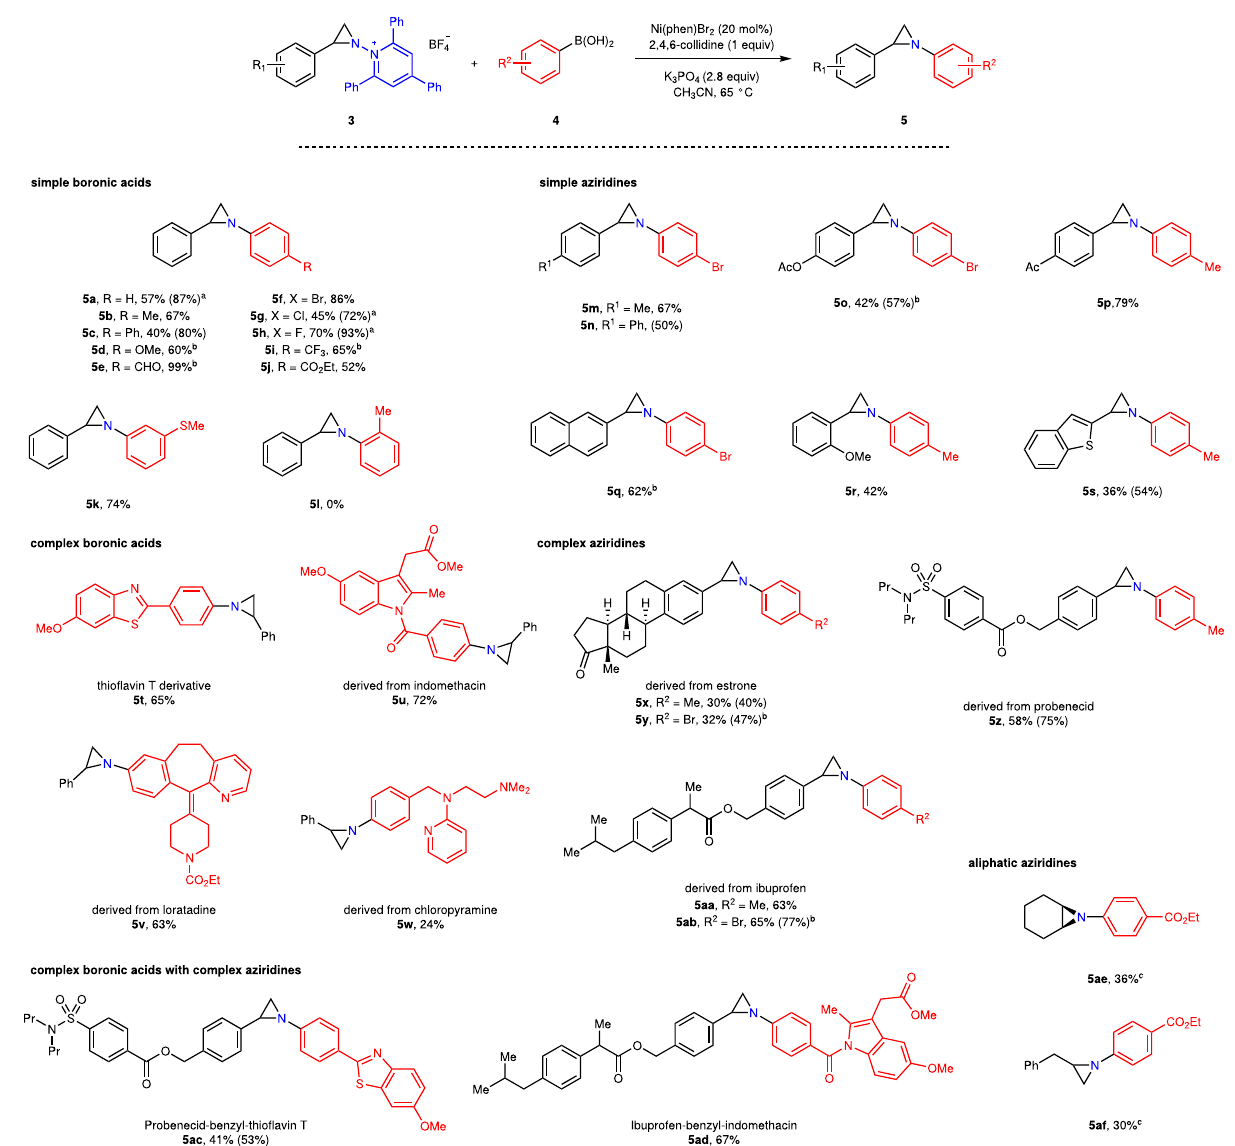
Fig. 3 Ni-catalyzed cross-coupling of N -pyridinium aziridines 3. Cross-coupling of 3 with aryl boronic acids provides access to N -arylaziridines, which are the products of formal transfer of aryl nitrenes to ole fi ns. a These reactions were carried out with 10 mol% Ni(phen)Br 2 . b For these substrates, K 2 CO 3 was used in place of K 3 PO 4 . c Prepared from the unsubstituted N -pyridinium aziridine (i.e. 3aa and 3ab ). Yields reported are based on isolated products (based on 1 H NMR integration). Phen =